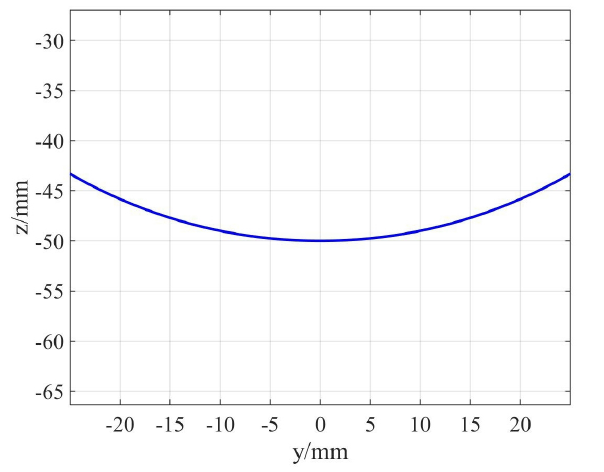
Figure 8. The motion path of the moving platform.